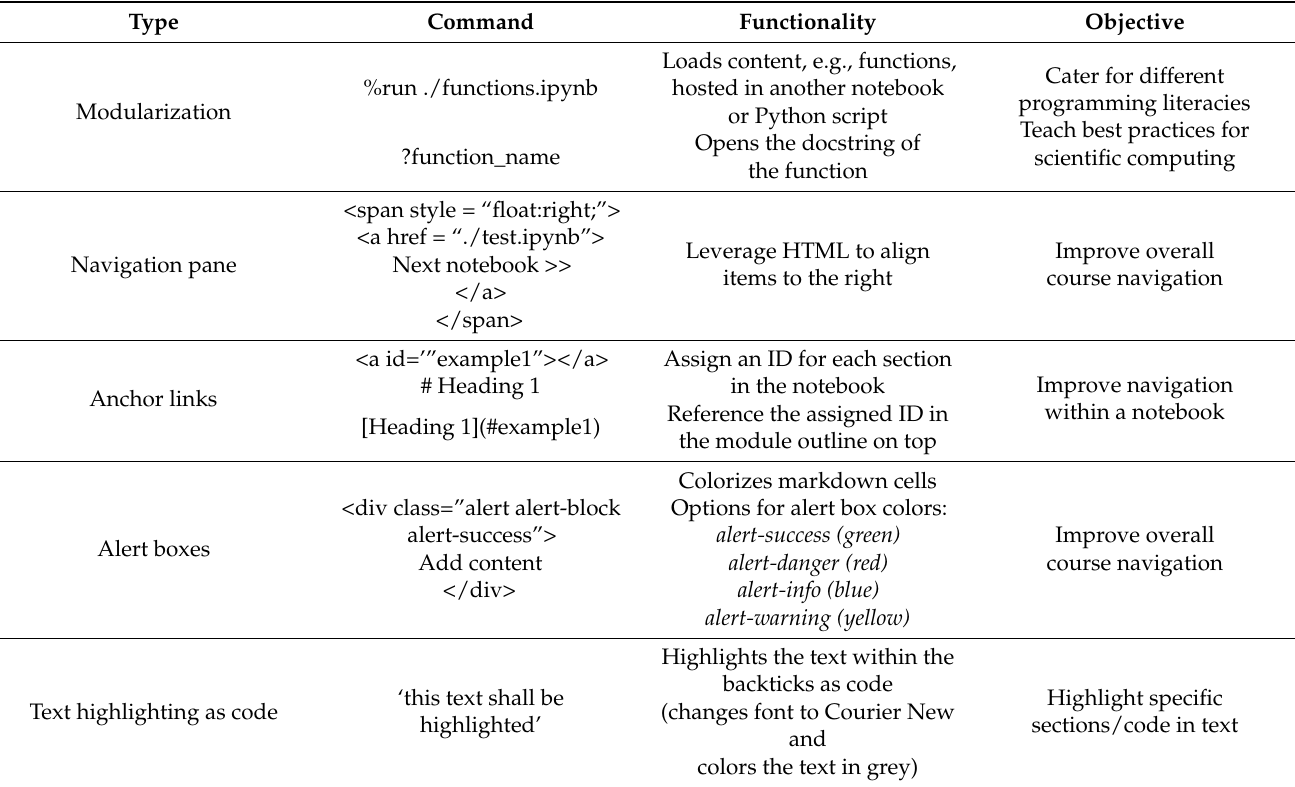
Figure 5. Overview of HTML/Markdown commands, which were used as instructional design ele- ments, and their rendered output: (i) alert boxes, (ii) navigation pane, (iii) highlighting text as code and (iv) anchor links.